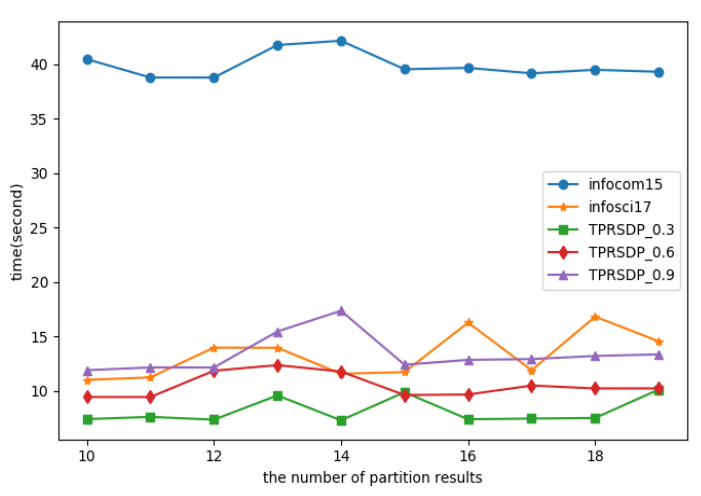
Figure 3. Time cost (T-drive dataset).